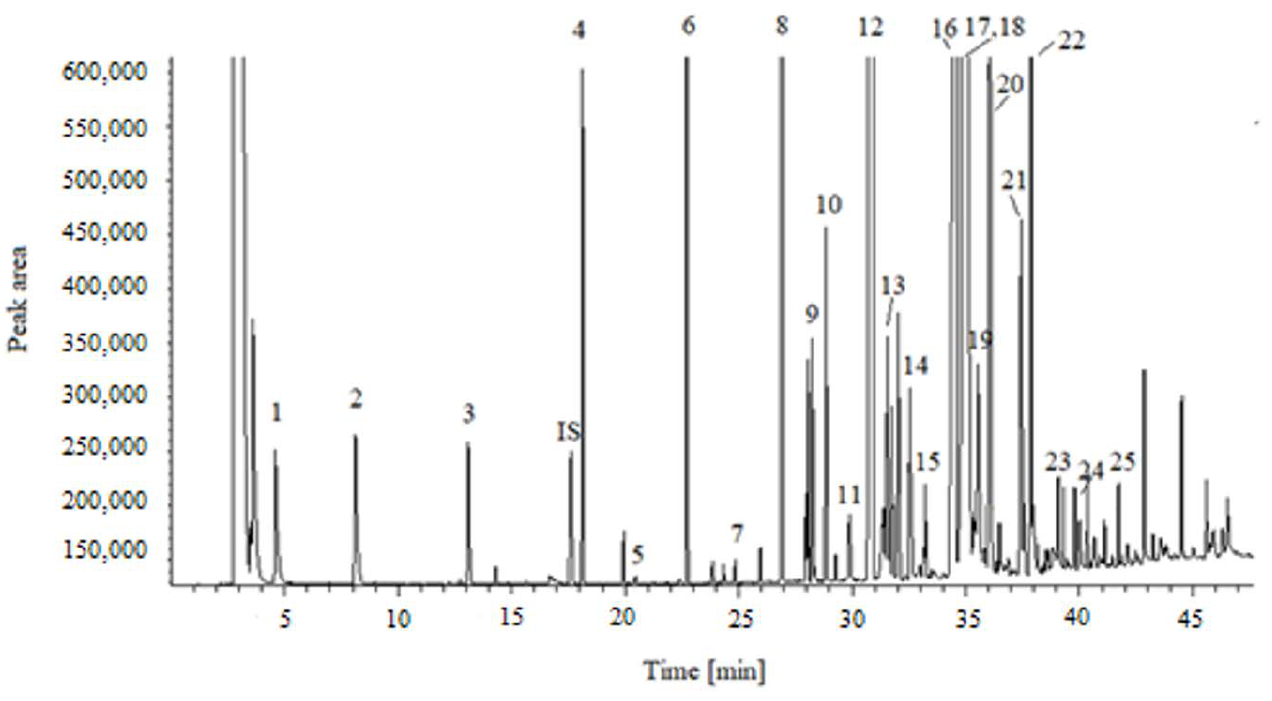
Figure 1. Typical chromatogram of milk lipid FAMEs. Peaks are: 1. butyric acid, 2. caproic acid,